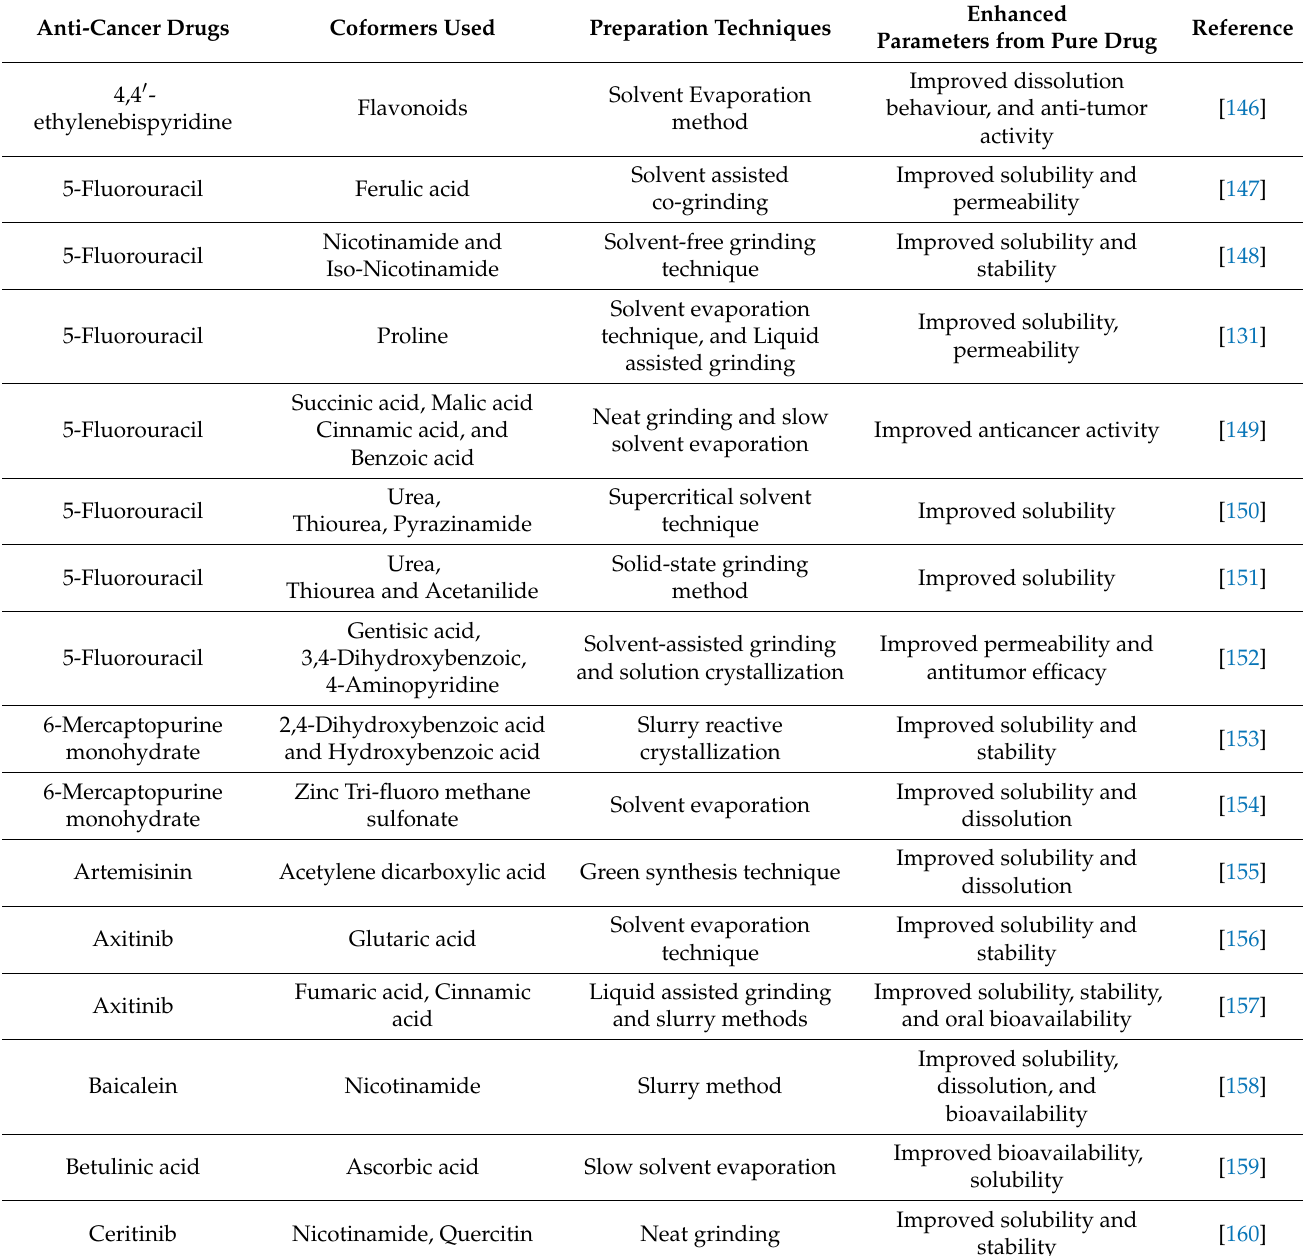
Table 1. A list of reported cocrystals of anti-cancer drugs, cocrystal preparation techniques, and its improved parameters from pure